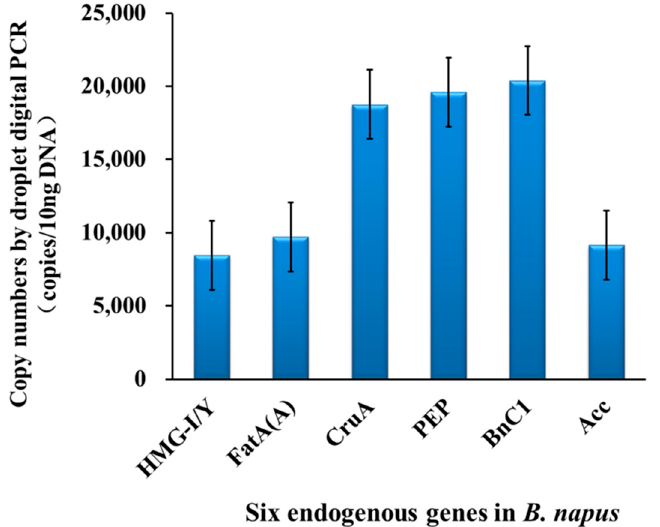
Figure 1. Average copy numbers for six ERGs (average of seven B. napus cultivars) plus standard deviation. For ddPCR, 12.5 ng DNA was used. The experimental data include all cultivars of Brassica napus , including GM canola of MS1, Oxy-235, and Topas 19/2 and four non-GM canola of AV-Jade, Zhongshuang-11, Nh No.345, and Zhongshuang–b.